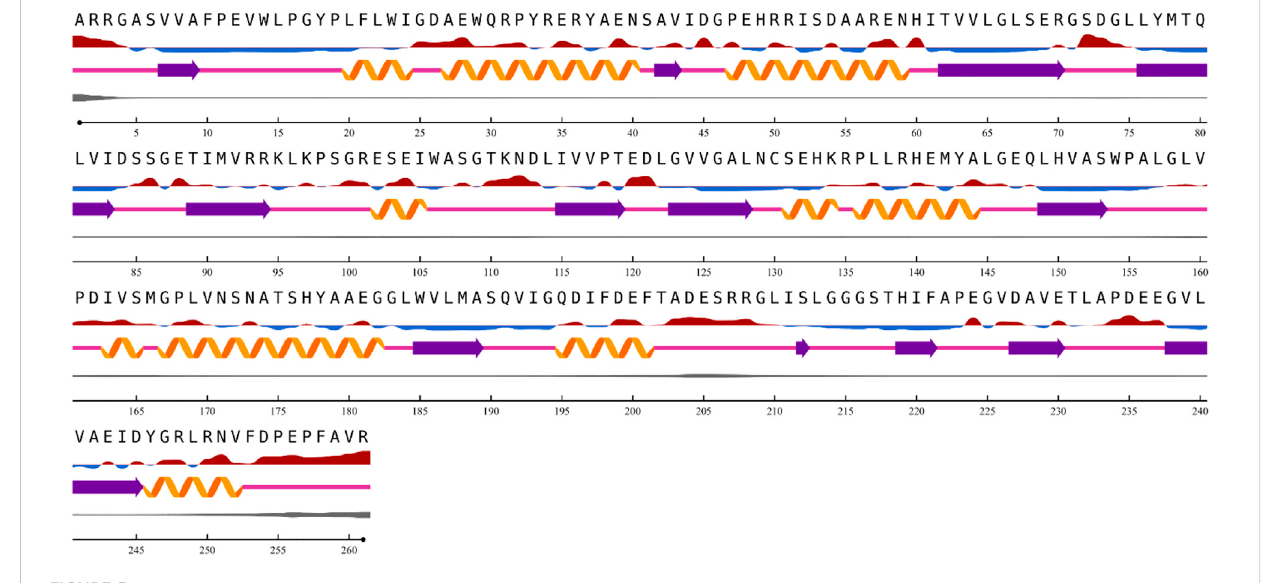
FIGURE 5 Prediction of nitrilase secondary structure.